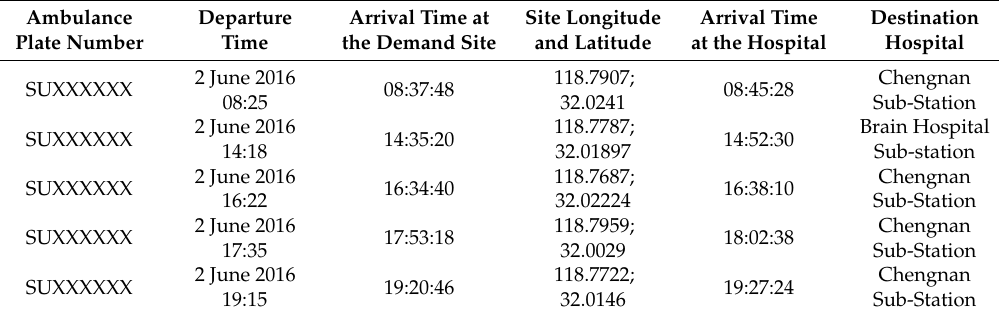
Figure 3. Map of pre-hospital emergency stations in Nanjing. Table 1. Example of GPS data for emergency service